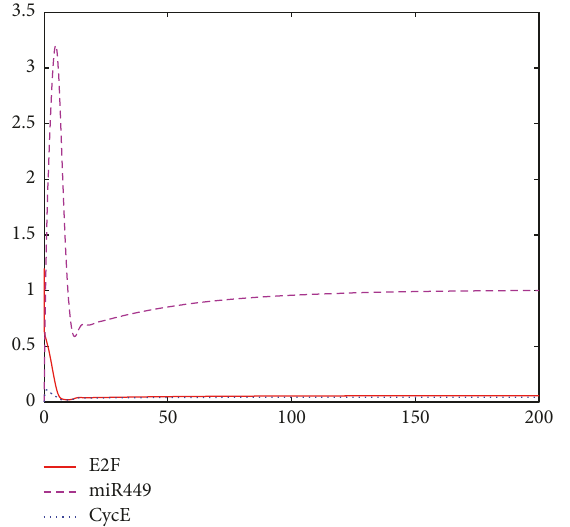
= 1.2, 𝑥 1 = 0, 𝑥 = 0 , and 𝑆 = 3, 𝑘 7 8